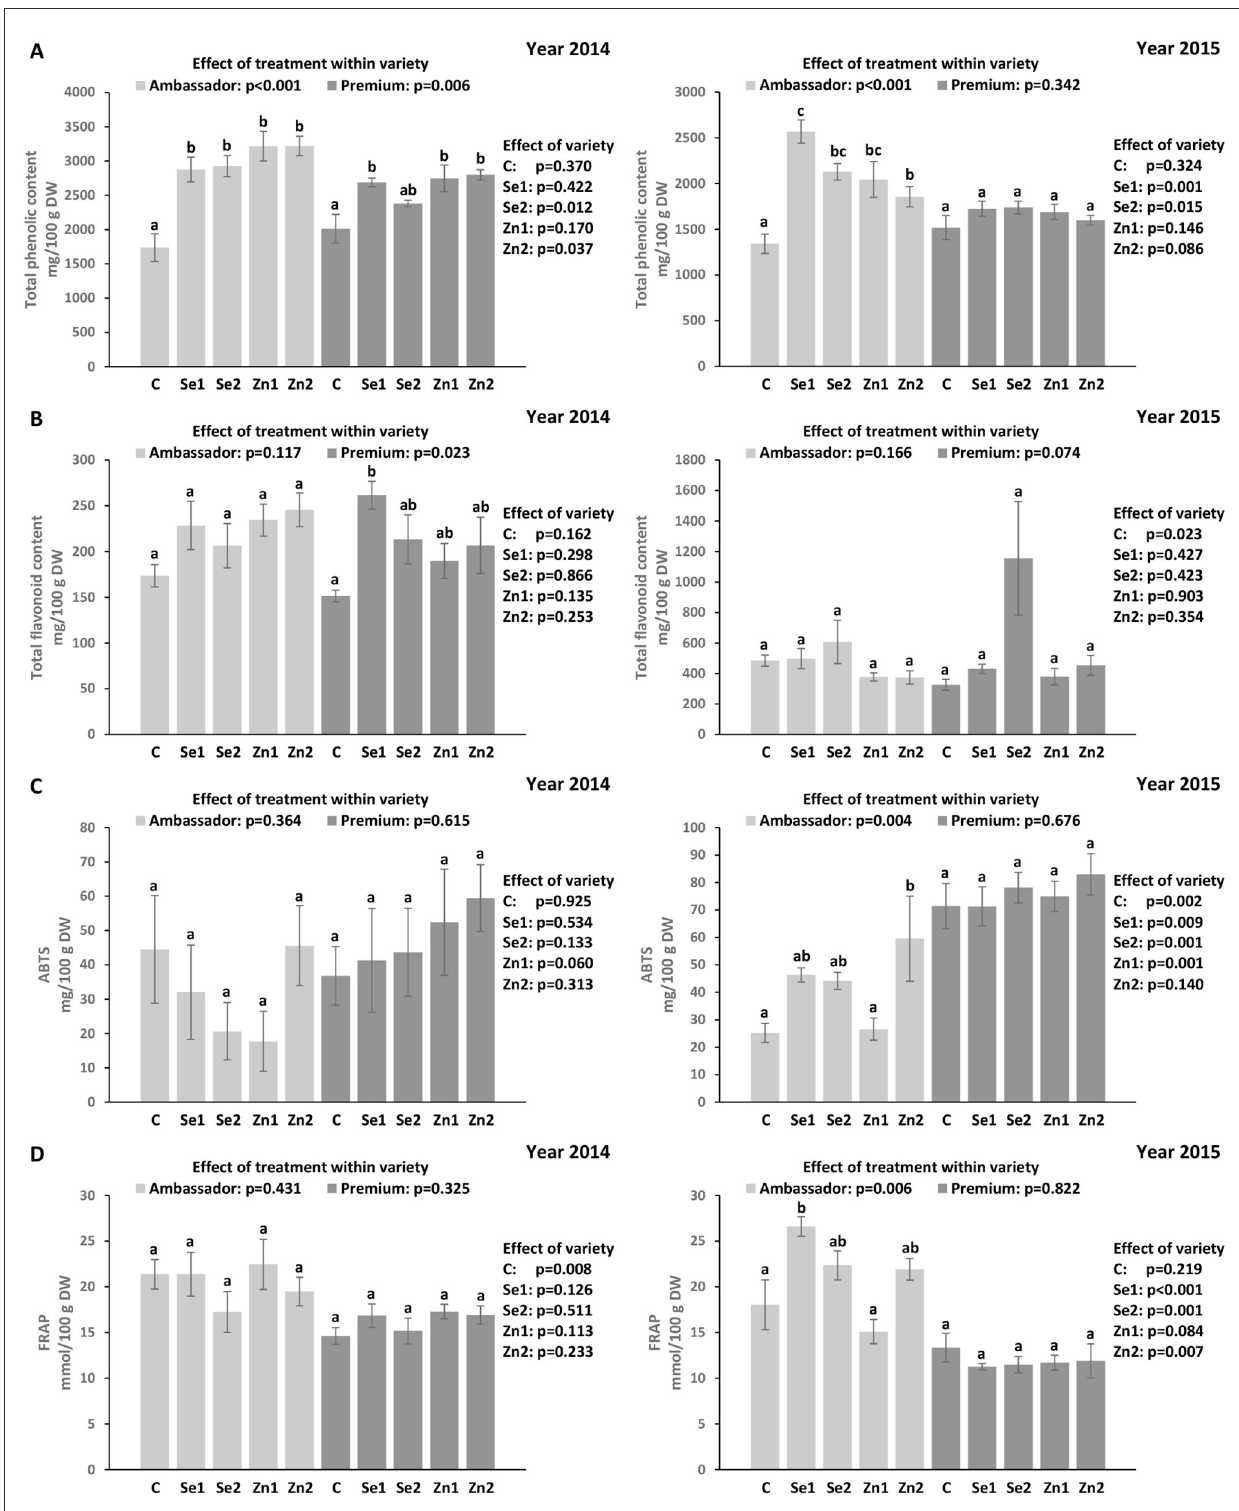
FIGURE1 Effect of foliar application of Se and Zn in two growing seasons (2014 and 2015) on total phenolic content (A) , total flavonoid content (B) , and total antioxidant activity (ABTS and FRAP) [ (C, D) , respectively] of pea seeds. C (control), without Se and Zn; Se1, 50g Se/ha; Se2, 100g Se/ha; Zn1, 375g Zn/ha; Zn2, 750g Zn/ha; mean ± SD; n = 4. Bars not sharing the same superscript are significantly different within varieties. P -values on the right side of the figure show the effect of treatment across the two varieties (i.e., Ambassador vs.